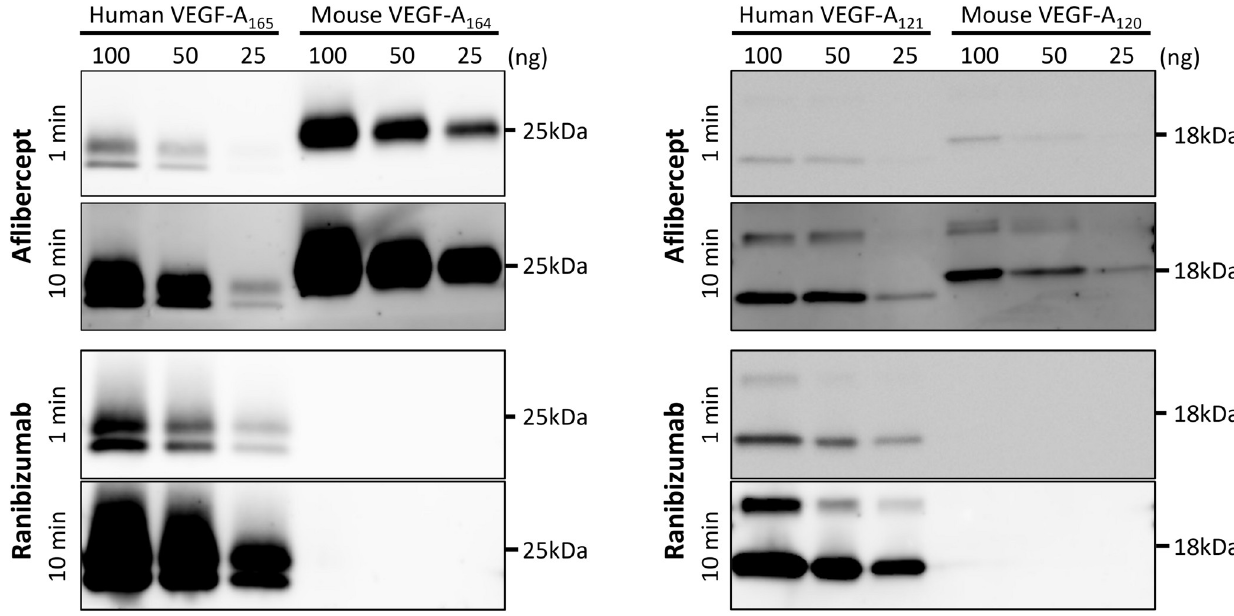
Fig 3. Western blot analysis of the interaction of recombinant human VEGF-A 165 , and mouse VEGF-A 164 , human VEGF-A 121 , and mouse VEGF-A 120 with aflibercept or ranibizumab as the primary antibody. The immunoreactive bands for mouse VEGF-A were observed in the aflibercept- probed blot, but not in the ranibizumab-probed blot even with long exposure time. VEGF, vascular endothelial growth factor.